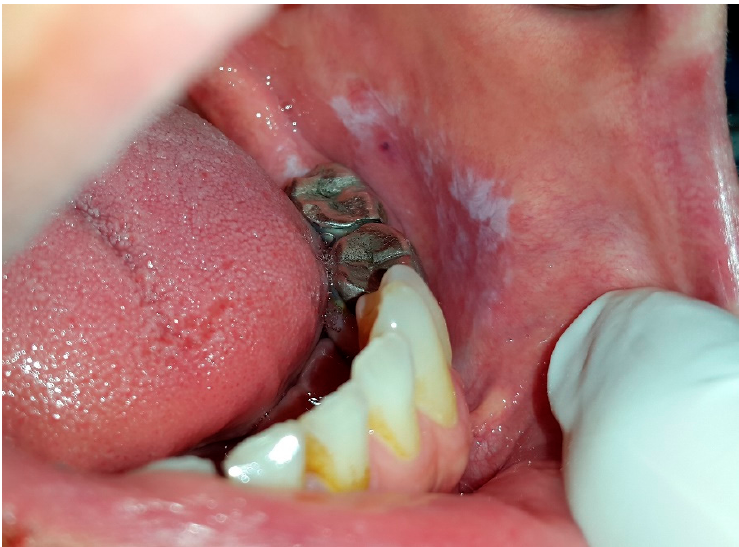
Figure 7. Lichenoid contact reaction in buccal mucosa and alveolar ridge due to amalgam build-up of 1st and 2nd mandibular molar.